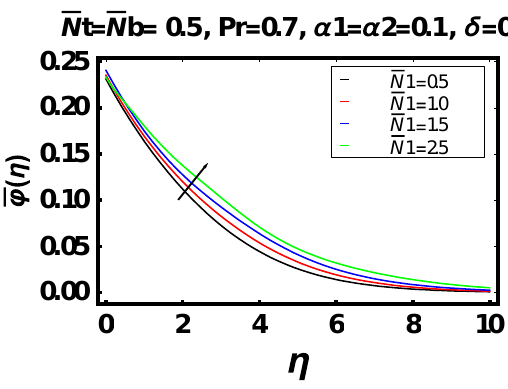
Figure 11. Concentration profile for variant N̅ 1 .